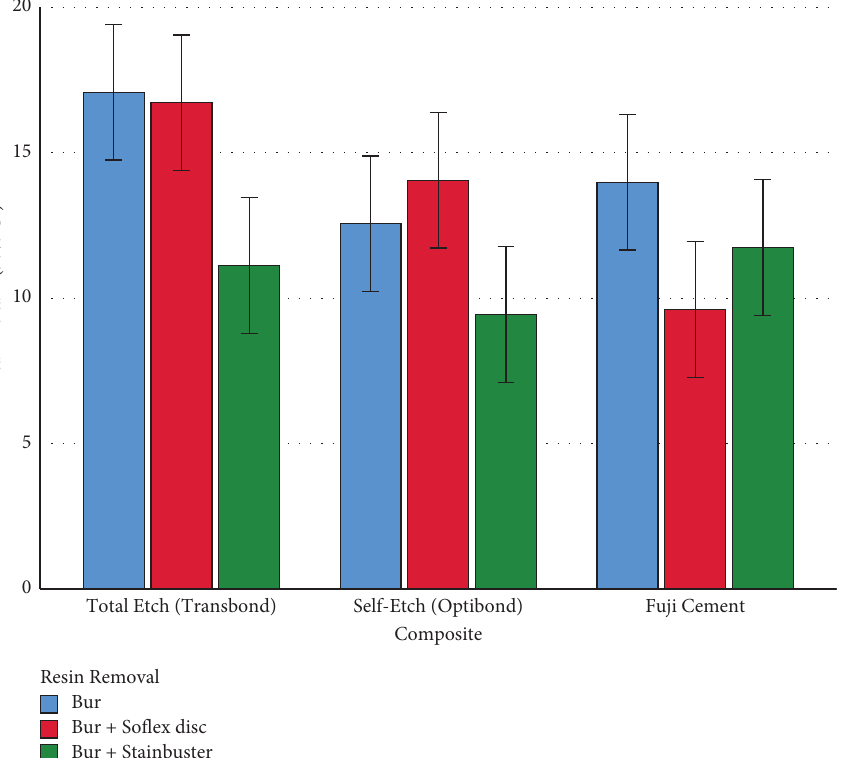
Figure 8: Means (and 95% CIs) for the Δ E parameter in all the 9 groups ( n � 9 × 10). Table 4: Pairwise comparisons performed using the Tukey test following signifcant ANOVAs applied for subgroup analyses (reported in Table